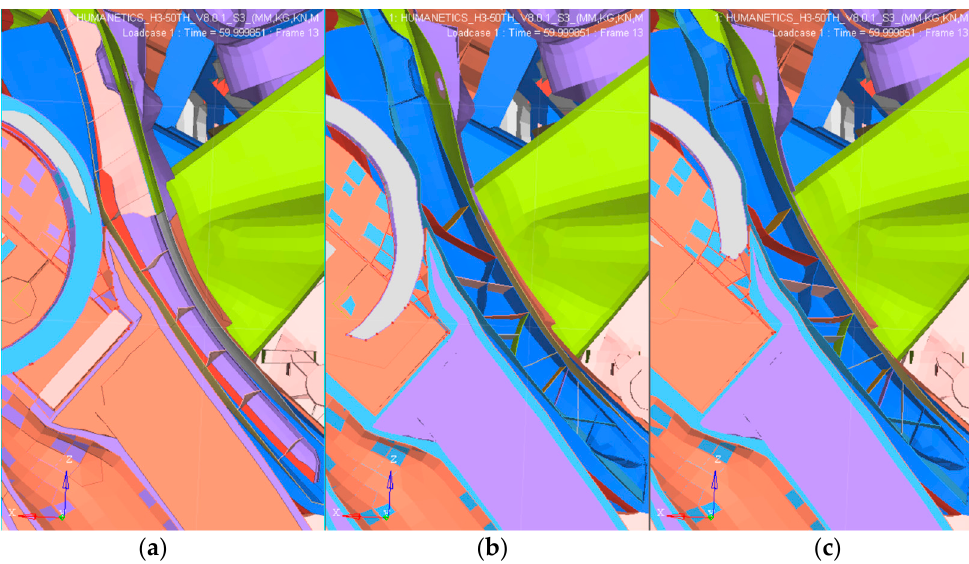
Figure 12. Leg impact. ( a ) The box currently in production, ( b ) the additive box with PA + 5% B, and ( c ) the additive box with PP + 5% B.